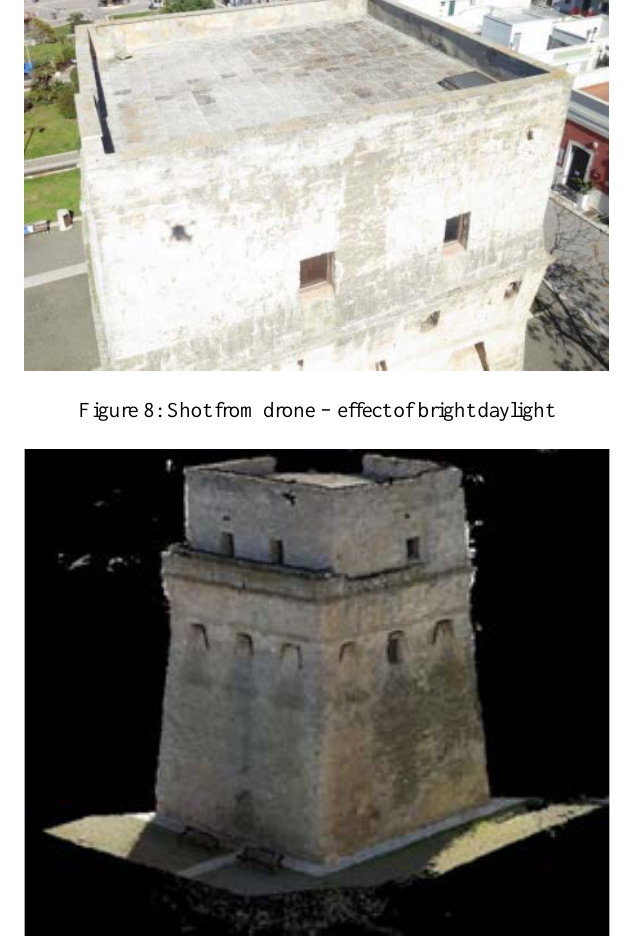
Figure 9: Point cloud model from drone